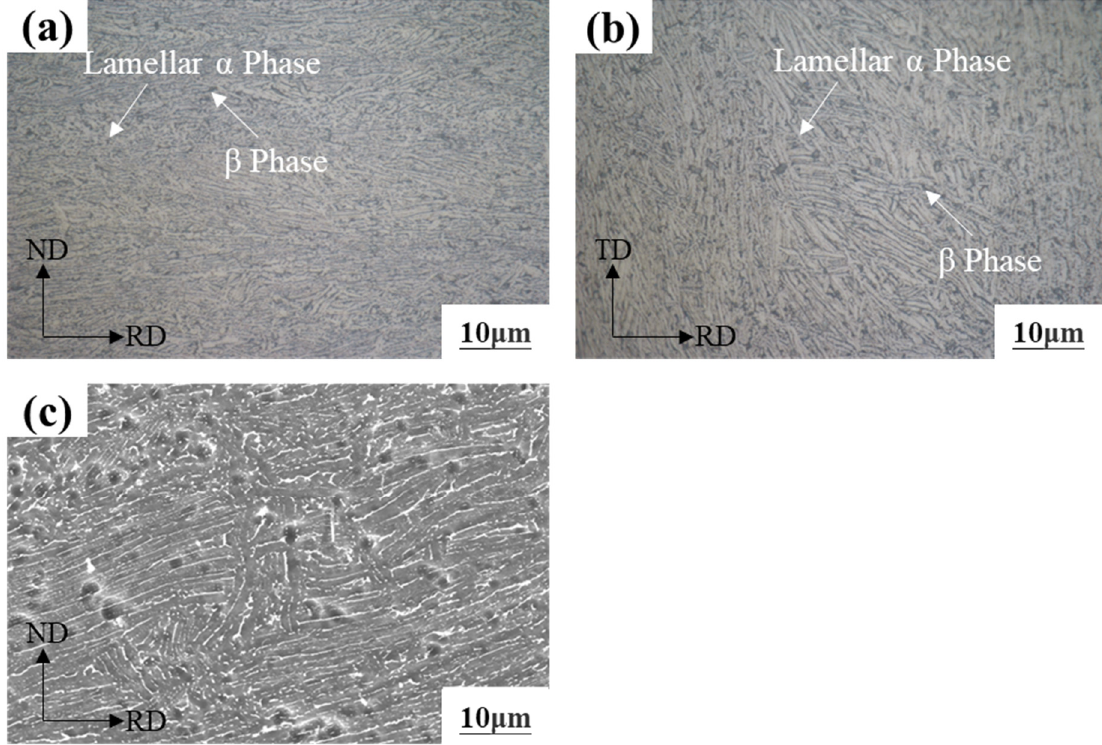
Figure 2. Microstructure of hot-rolled TA10 alloy sheets: ( a ) longitudinal section; ( b ) cross-section; ( c ) SEM.